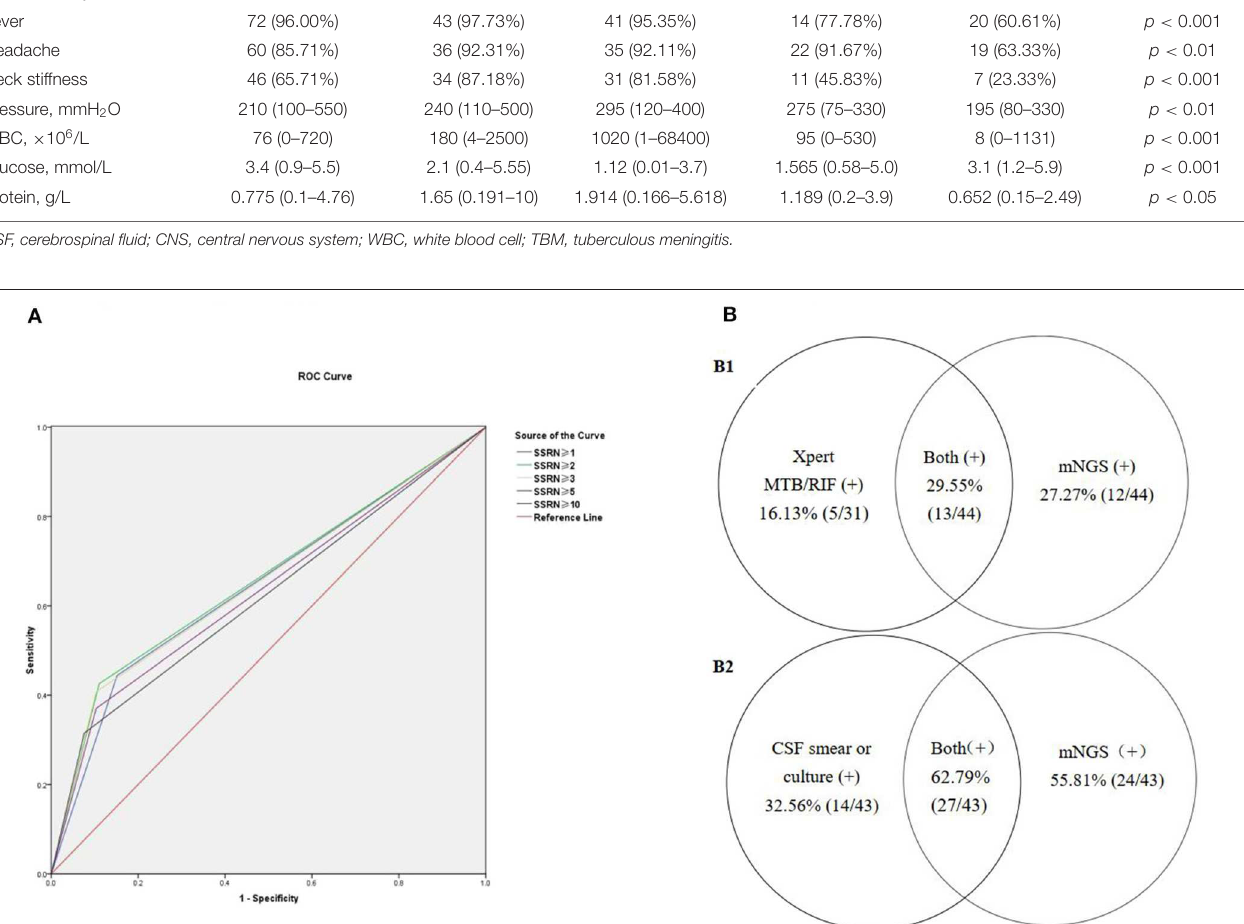
positive if the SSRNs were ≥ 2, 3, 5, 10, and 15; the positive consistency rates were 62.8, 62.8, 55.8, 55.8, and 51.2%, respectively. The negative consistency rates were 82.9, 87.6, 95.9, 95.9, and 95.9%, respectively; total consistency rates were 78.9, 82.6, 87.8, 87.8, and 86.9%, respectively. The AUCs for the five positive mNGS criteria were 0.729, 0.752, 0.758, 0.758, and 0.735, respectively. When SSRNs ≥ 5 or 10 were considered positive, the AUC (0.758, 95% CI = 0.663–0.854) was largest. The sensitivity, specificity, positive predictive value, and negative predictive value of mNGS in the diagnosis of 15 patients with definite bacterial meningitis were 73.3, 95.9, 61.1, and 97.6%, respectively